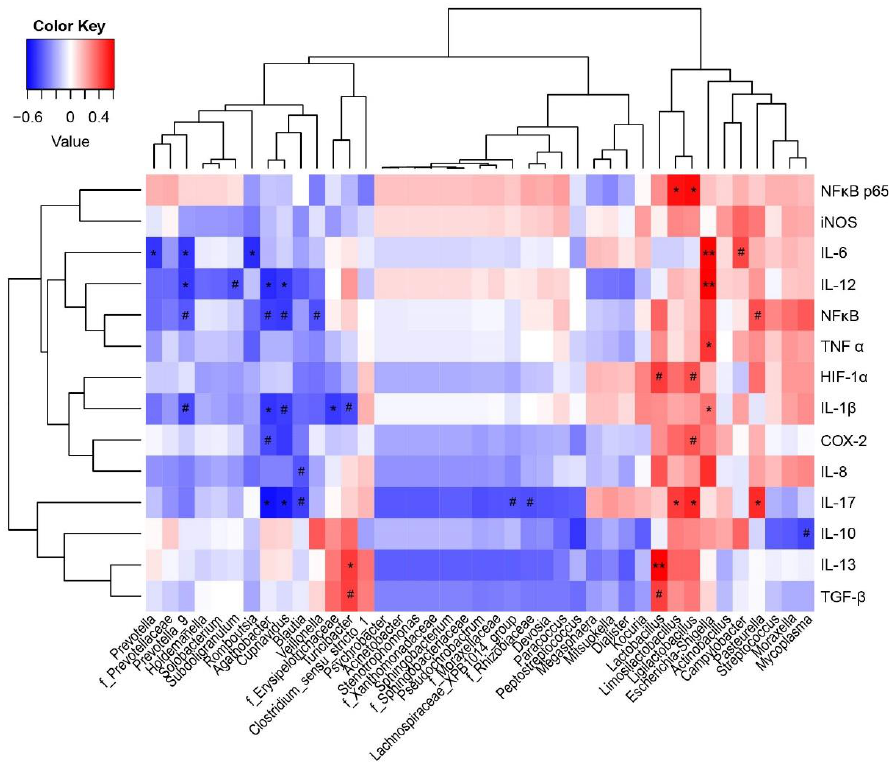
Figure 5. Correlations between jejunal microbiota and immune parameters. Red indicates a positive correlation and blue indicates a negative correlation. * p < 0.05 and ** p < 0.01 indicate significant and extremely significant correlations, while # 0.05 < p < 0.01 represents a correlation